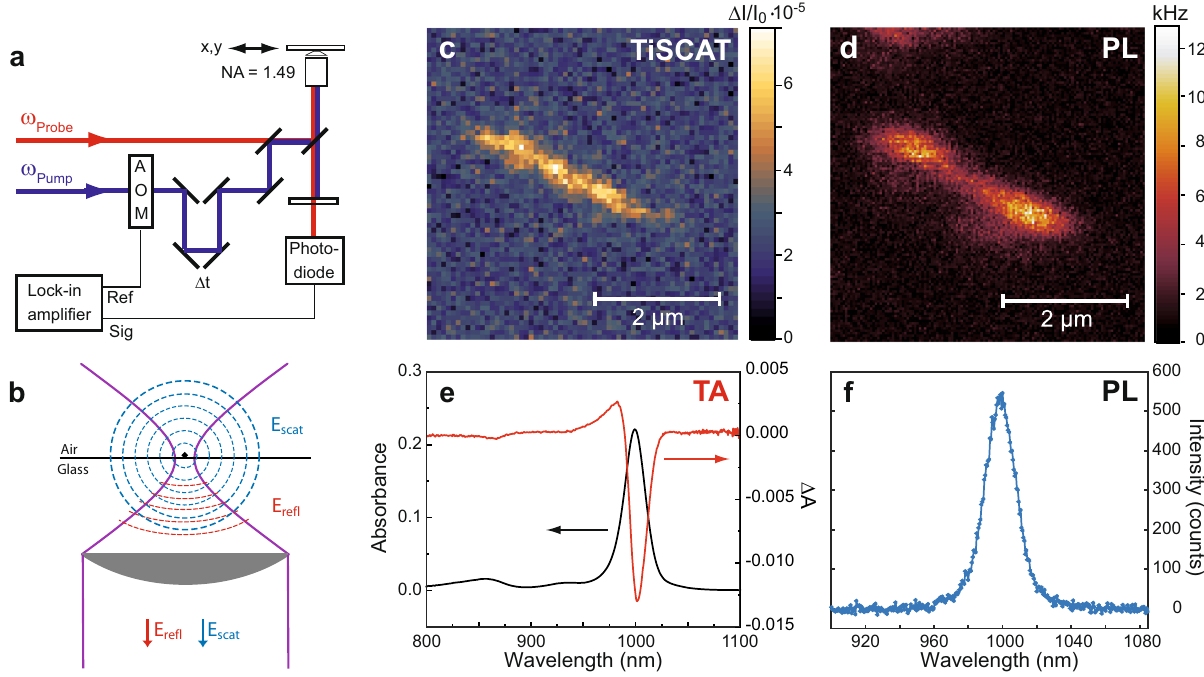
Fig. 1 | Transient interferometric scattering microscopy of single SWCNTs. a Schematic of confocal microscopy setup for the sensitive detection of transient probe intensity changes due to few created excitons per excitation pulse. b In transient interferometric scattering, the detected intensity results from the inter- ference between the fi eld re fl ected by the glass substrate ( E re fl ) and the fi eld scat- tered by the SWCNT ( E scat ). Confocal transient interferometric scattering c and PL image d of a single (6,5) nanotube on glass. For both images, the nanotube was